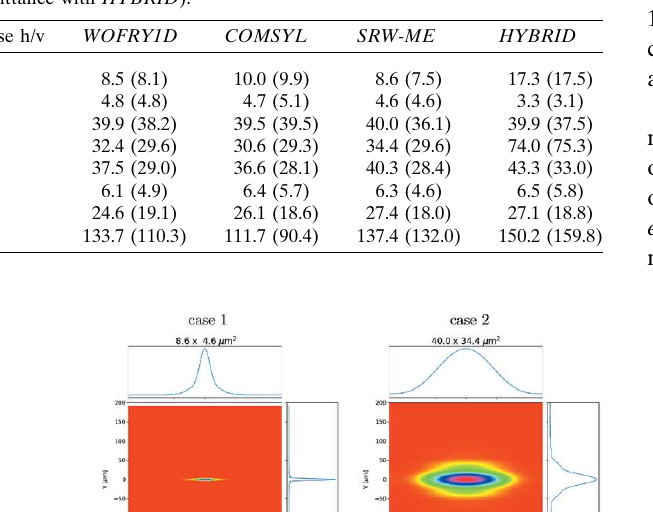
Table 2 Comparison of sizes (FWHM, in m m) calculated with different methods for the cases defined in Table 1. Numbers in brackets are the values for the fully coherent beam (single electron with SRW , first coherent mode with COMSYL / WOFRY , and zero emittance with HYBRID ).